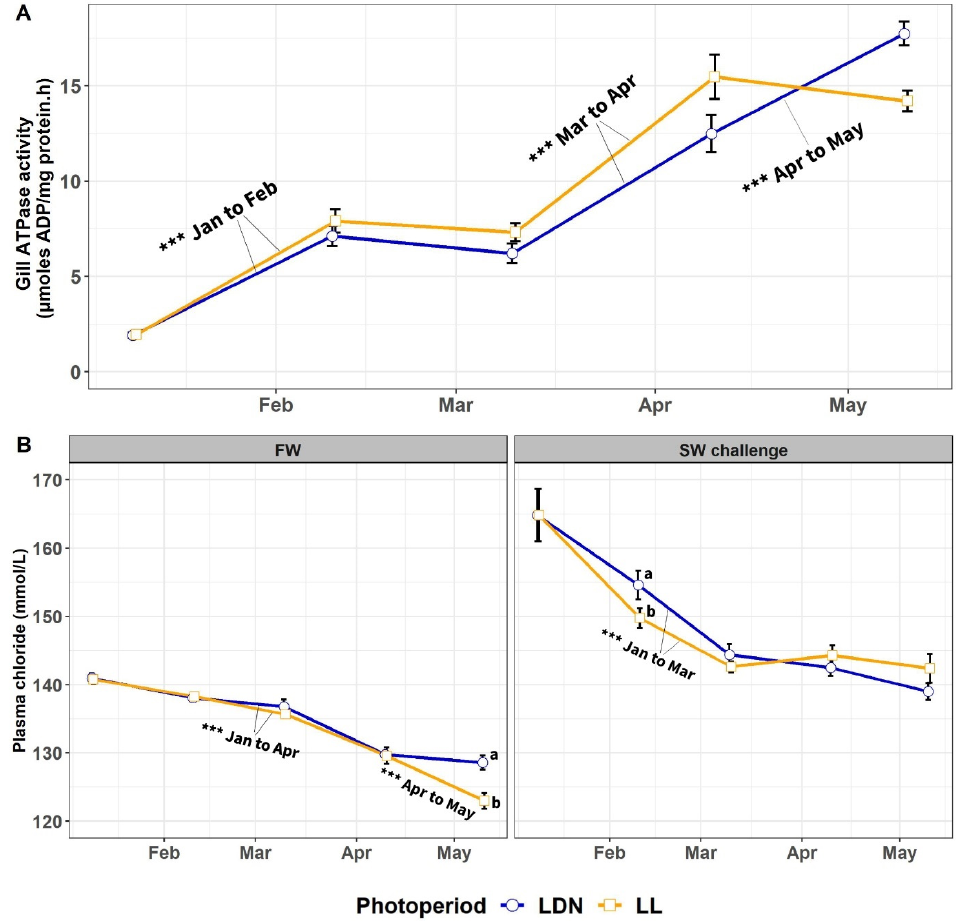
Figure 4. Gill NKA activity ( A ) and plasma chloride concentration in freshwater and after a 24-h sea water challenge ( B ) in both photoperiod groups during smoltification. Asterisks represent significant differences over time, indicated by *** ( p < 0.001, two-way nested ANOVA). Letters “a” and “b” represent significant differences ( p < 0.05) between photoperiod groups at a given time (Tukey post hoc tests). Vertical lines indicate SEM.